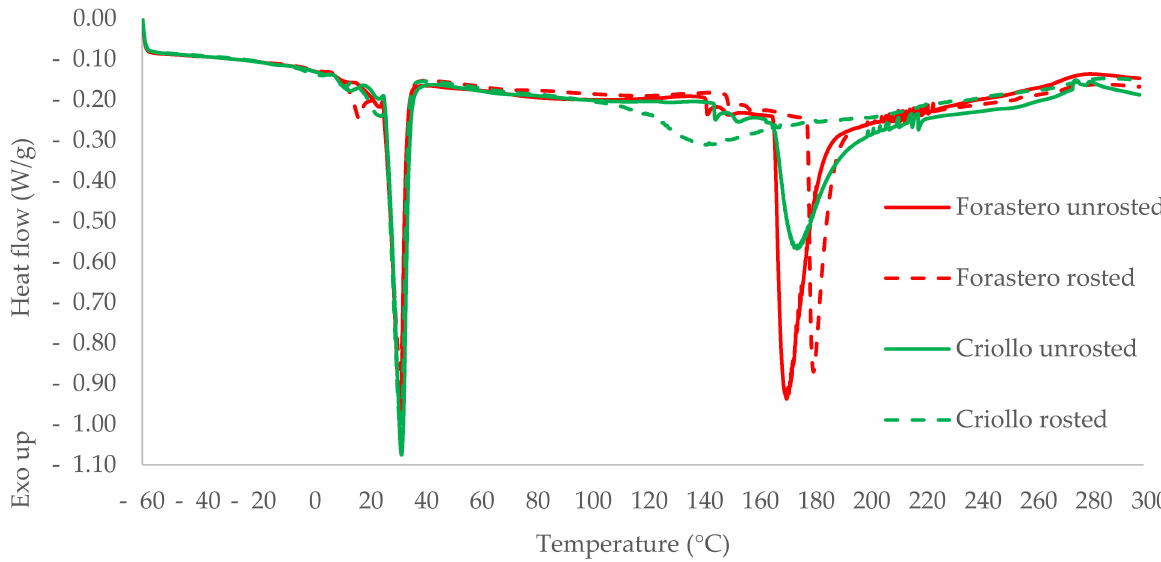
Figure 1. Differential scanning calorimetry (DSC) curves of ground, roasted and unroasted, Criollo (Peru) and Forastero (Ecuador) powdered cocoa